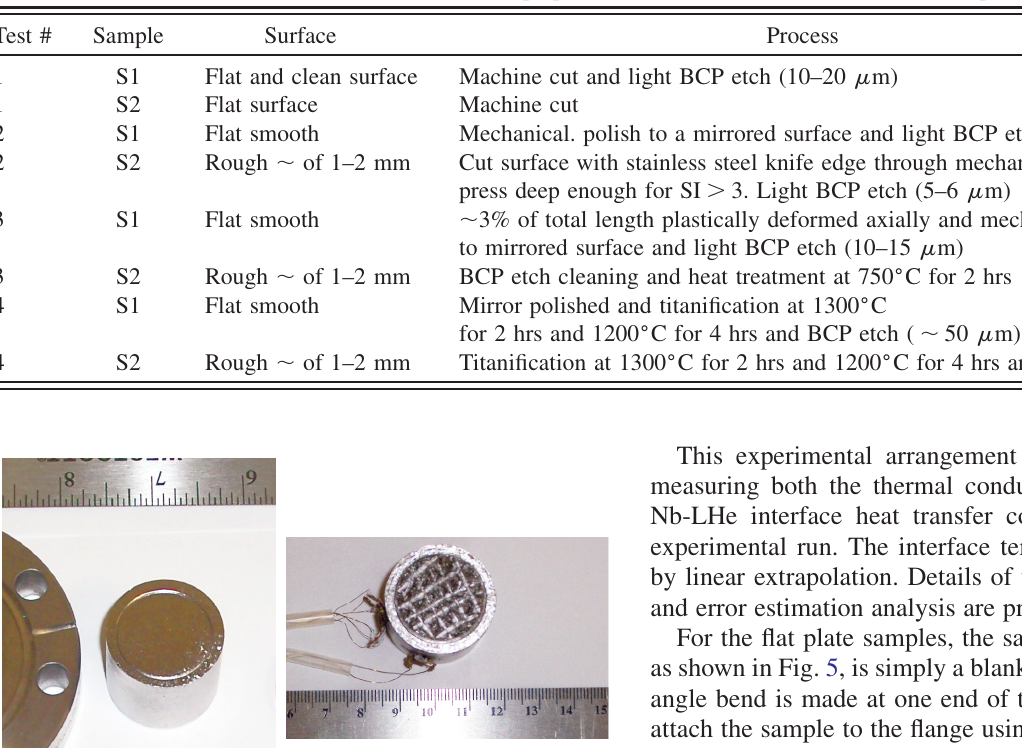
TABLE I. Surface and bulk preparation of the two cylindrical niobium samples.